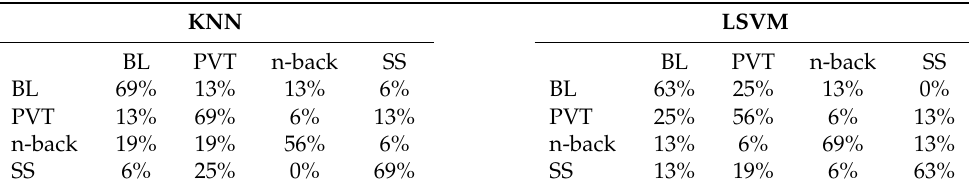
Table 3. Confusion matrices for the KNN and LSVM classifiers.